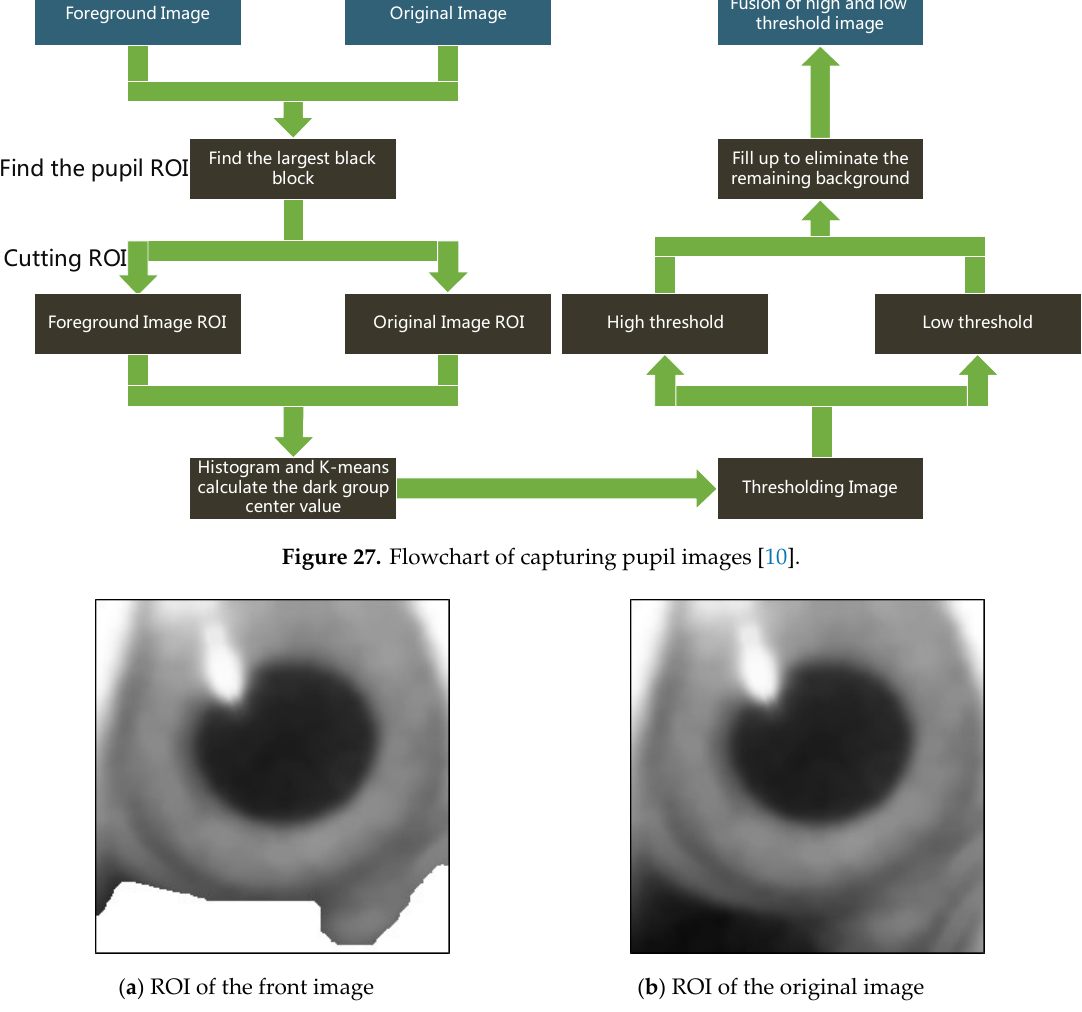
Figure 28. Region of interest (ROI) of the image.